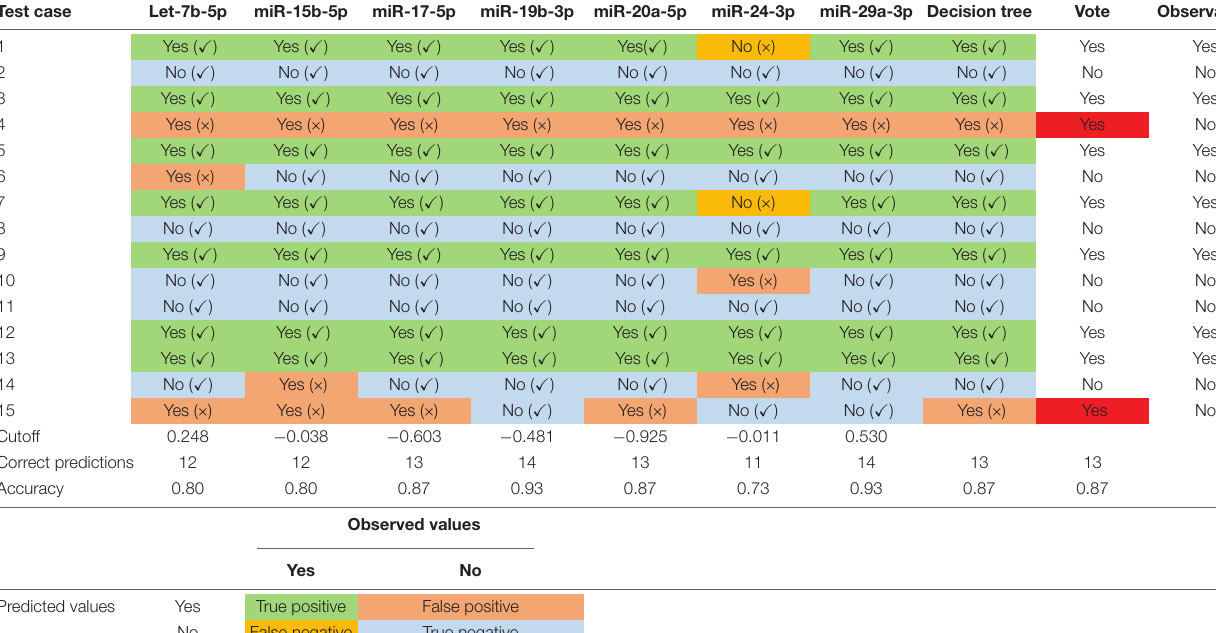
TABLE 4 | Overall performance of DCV risk prediction of the custom miRNA panel. Test case